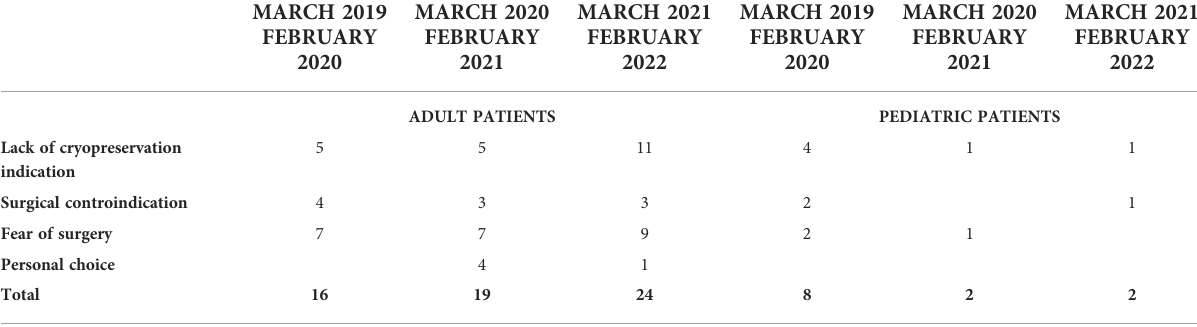
TABLE 4 Reasons for the OTC failure from March 2019 to March